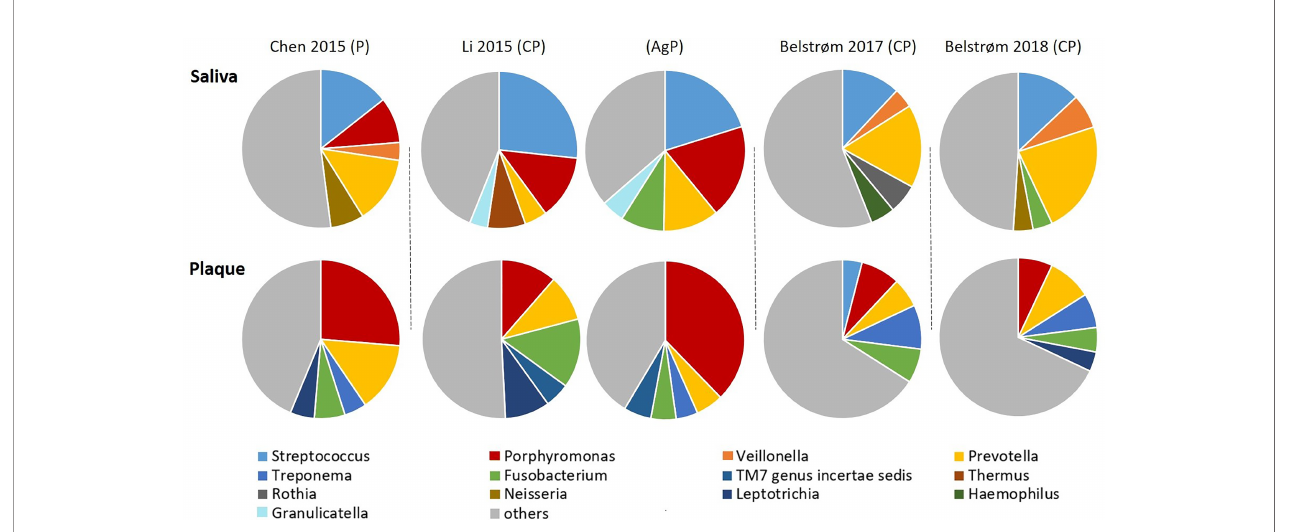
FIGURE 7 | Approximate relative abundance of the top 5 most abundant genera identi fi ed in saliva and subgingival plaque from patients with periodontitis, as determined in studies using 16S rRNA gene sequencing techniques. CP, chronic periodontitis; AgP, aggressive periodontitis; P, periodontitis unclassi fi